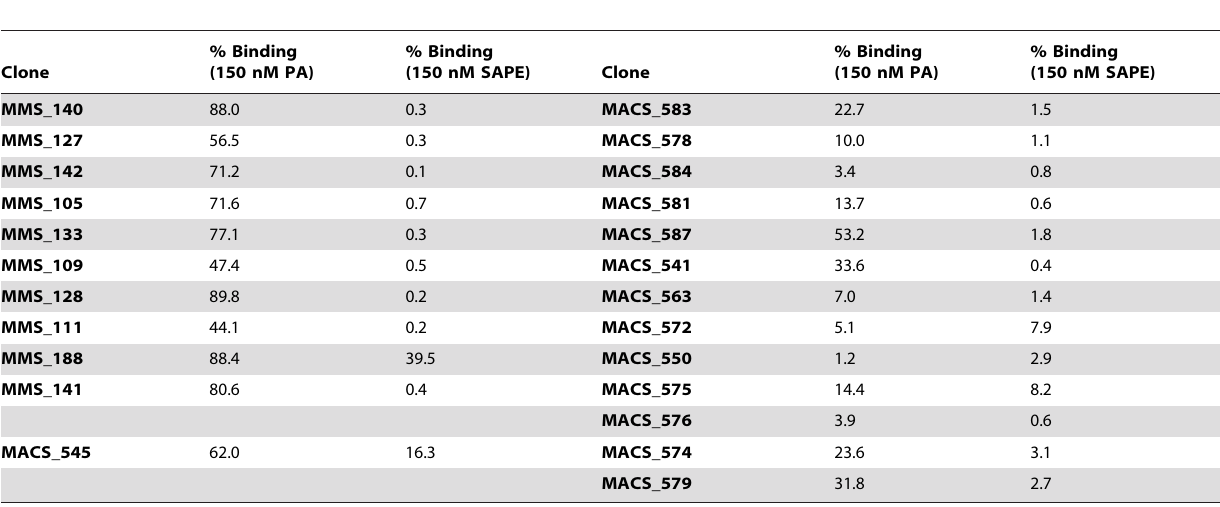
Table 1. PA and Streptavidin binding analysis of Single Clones: The percentage binding from flow cytometry of ten of the MMS isolated clones and fourteen MACS/FACS isolated clones.